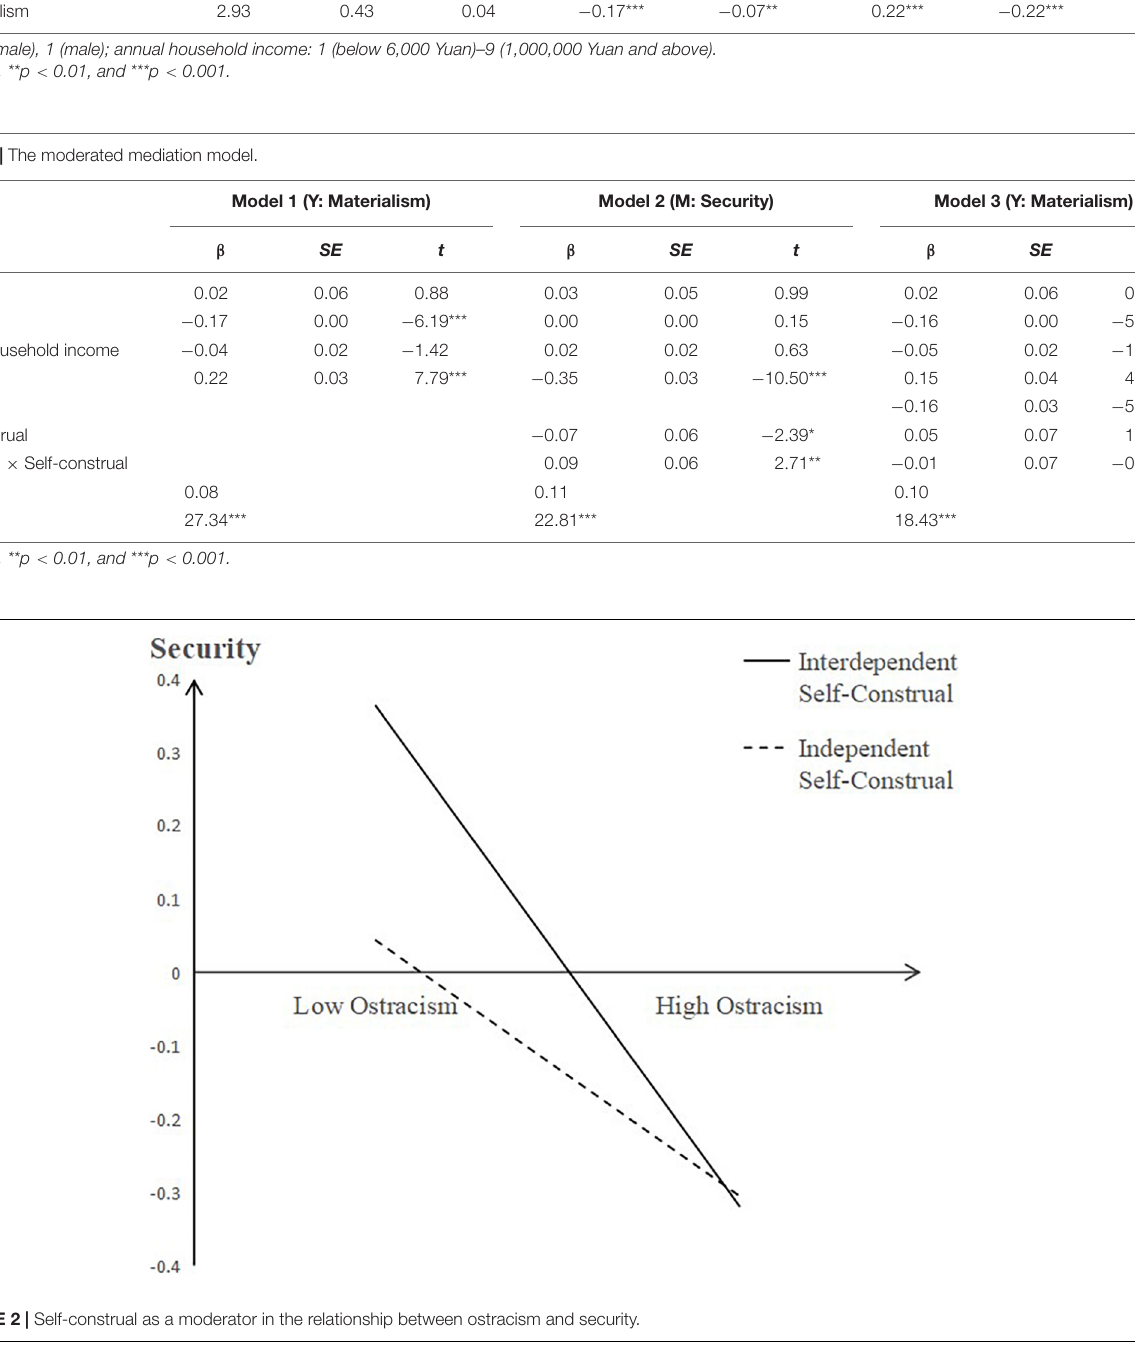
Frontiers in Psychology |